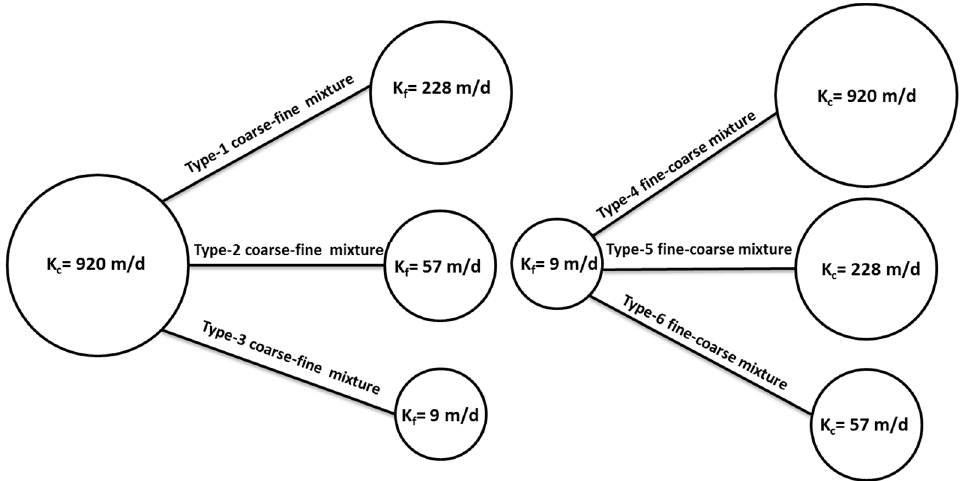
Figure 1. Schematic diagram illustrating the two sets of coarse-fine and fine-course porous media mixtures used in our laboratory experiments. K is hydraulic conductivity in m/day, the subscripts c and f stand for the coarse and fine particles. Each type of mixture was prepared with seven different fine percent levels: 0%, 5%, 10%, 15%, 20%, 25%, and 30%.